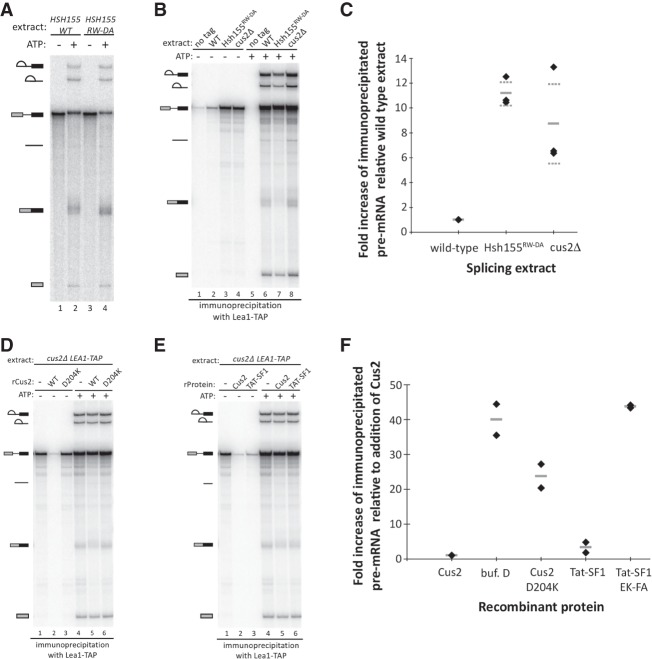
The interaction between the UHM of Cus2 and the ULM of Hsh155 is functionally conserved, and disruption of the interaction permits pre-spliceosome assembly in the absence of ATP. (A) In vitro analysis of splicing of radiolabeled actin pre-mRNA. Pre-mRNA was incubated with either wild-type or Hsh155RW-DA splicing extracts for 20 min with or without ATP. RNA was extracted from the reactions, resolved on a 6% acrylamide/8M urea gel, and visualized by autoradiography. Precursor, intermediates, and products are indicated. (B) Coimmunoprecipitation of splicing complexes with Lea1-TAP in wild-type, Hsh155RW-DA, and cus2Δ extracts in the presence or absence of ATP. Reactions were set up as described in A. Following the reaction, Lea1-TAP-containing splicing complexes were immunoprecipitated with IgG-conjugated magnetic beads. After extensive washing of the beads, RNA was extracted, resolved on a denaturing acrylamide gel, and visualized with autoradiography. Coimmunoprecipitation of pre-mRNA in the absence of ATP serves as a proxy for ATP-independent pre-spliceosome formation. A “no tag” extract serves as a control for background binding of splicing complexes to the IgG-conjugated beads. The autoradiograph shown is representative of triplicate experiments. (C) Quantification of triplicate experiments described in B indicating the fold increase of immunoprecipitated pre-mRNA by Lea1-TAP from cus2Δ and Hsh155RW-DA extracts relative to the wild-type extract in the absence of ATP. Data points are indicated by diamonds, the mean is indicated by a solid gray line, and the SD of the mean is indicated by dashed gray lines. (D) Reinforcement of ATP-dependent pre-spliceosome assembly by addition of recombinant Cus2 proteins. Cus2Δ Lea1-TAP extract was depleted of ATP in the presence of either buffer D or 500 nM wild-type or D204K mutant recombinant Cus2. Pre-mRNA and either water or ATP was then added to the extract and splicing was allowed to proceed for 20 min. Splicing complexes were purified and coimmunoprecipitated RNA was extracted and visualized as described in B. (E) Reinforcement of ATP-dependent pre-spliceosome formation by addition of recombinant Cus2 or Tat-SF1. Cus2Δ Lea1-TAP extract was depleted of endogenous ATP in the presence of either buffer D or 500 nM recombinant Cus2 or 1 µM Tat-SF1. Pre-mRNA and either water or ATP was then added to the reactions and splicing was performed for 20 min. Splicing complexes were purified and coimmunoprecipitated RNA was extracted and visualized as described in B. Autoradiographs shown in D and E are representative of duplicate experiments. (F) Quantification of duplicate experiments shown in D and E indicating the fold increase of ATP-independent immunoprecipitated pre-mRNA by Lea1-TAP from reconstituted splicing reactions relative to the addition of recombinant wild-type Cus2. Data points are indicated by diamonds and the mean is indicated by a solid gray line.